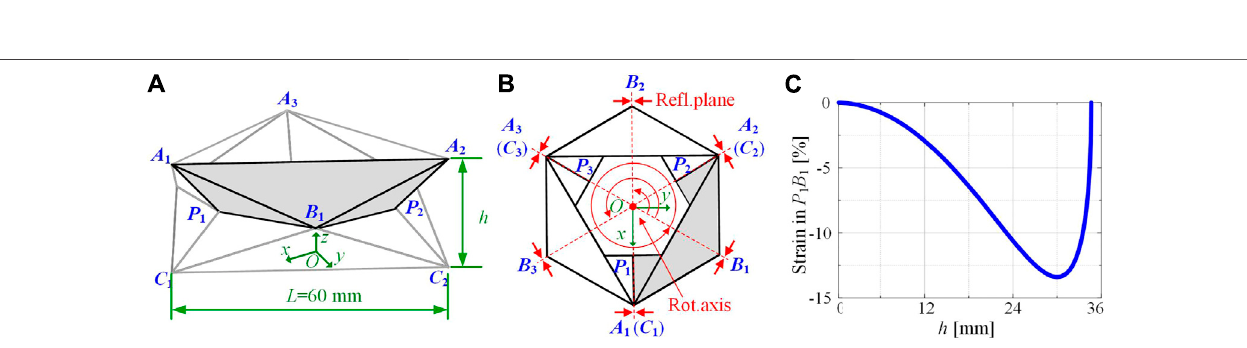
FIGURE2| Asingle-layerYoshimura-oristructureandthetheoreticalstrainchangeofthecrease P 1 B 1 . (A) Asingle-layerYoshimura-oristructure.Theshadedarea representsarectangle “ unit ” tobestudied. (B) Top-downviewofthestructure.TheoriginoftheO-xyzcoordinatesystemlocatesatthecentroidoftheequilateraltriangle C 1 C 2 C 3 , the x-axis is chosen to intersect vertex C 1 , the z-axis is the rotational axis that is perpendicular to the plane C 1 C 2 C 3 , and the y-axis follows the right-hand rule convention. The re fl ectional and rotational symmetry of the structure is also indicated. (C) Theoretical strain in P 1 B 1 as a function of the height h .